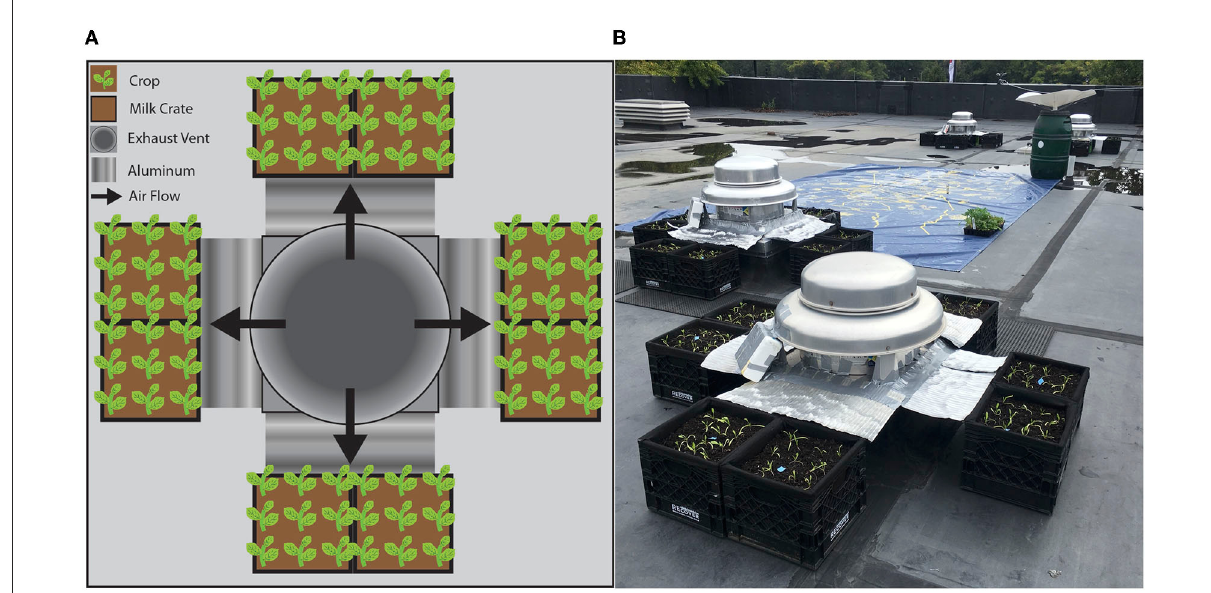
FIGURE2 Experimental garden set up around rooftop Exhaust Vents and Control Fans. This shows (A) a diagram of the experimental set up at one vent/fan and (B) a picture of the actual set up. Spinach and corn were planted in milk crates provided by Recover Green Roofs positioned next to various vents for four and a half weeks until harvest after which growth was